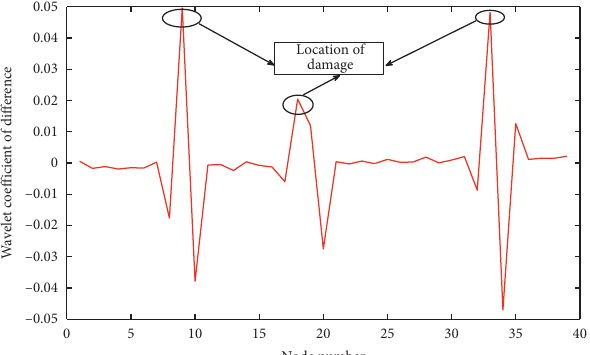
Figure 10: Wavelet coefficient difference for 10% damage in sections 9, 19, and 34.